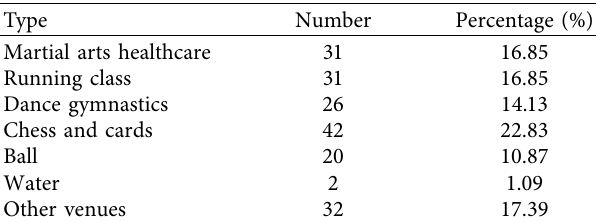
Table 6: Proportion of various venues suitable for the elderly to exercise ( n �